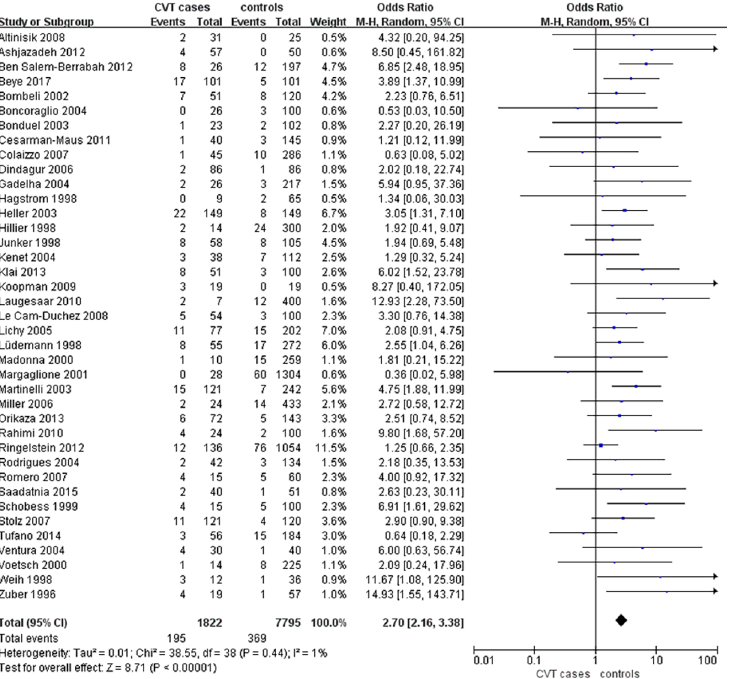
Fig 2. Forest plot of overall prevalence of FVL in CVT patients as compared with controls. CI, confidence interval; CVT, cerebral venous thrombosis.